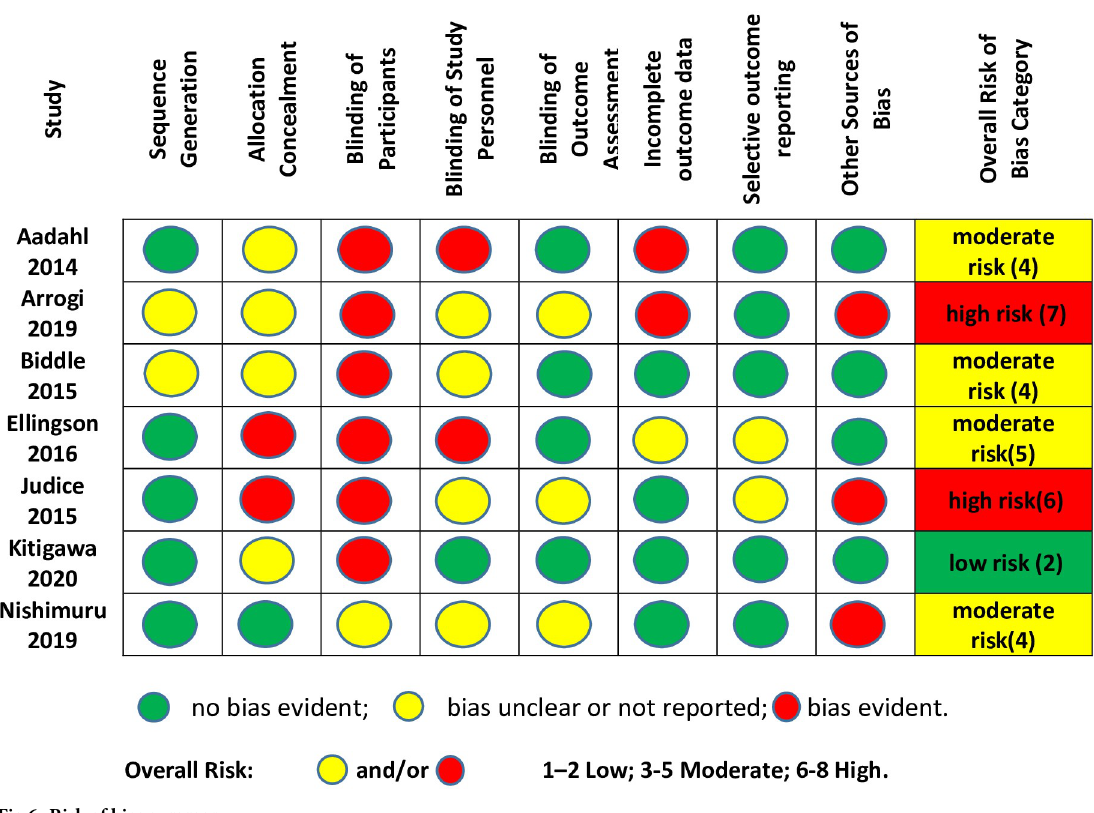
Fig 6. Risk of bias